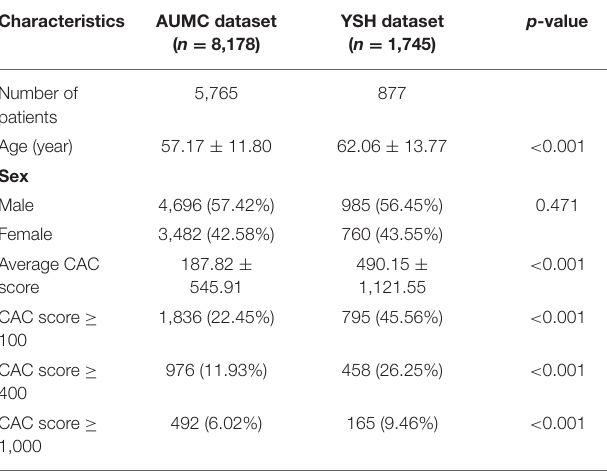
TABLE 1 | Dataset characteristics. Characteristics